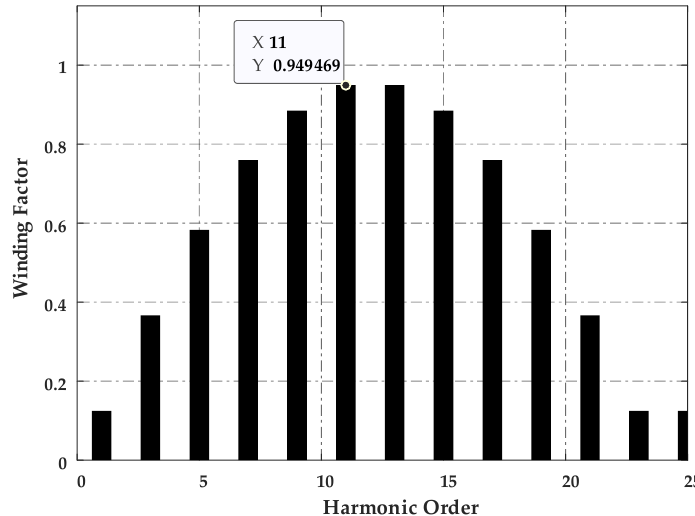
Figure 4. Harmonic spectrum of the winding factor.